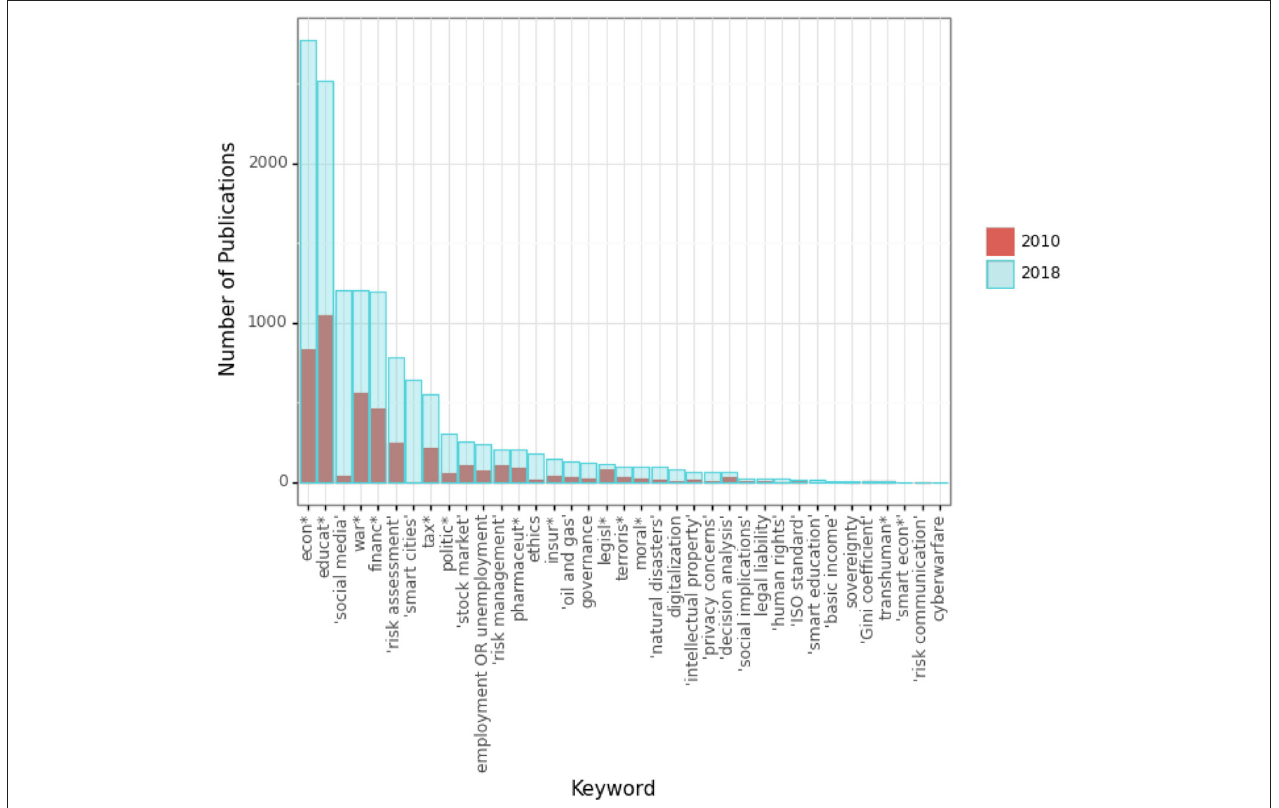
FIGURE 5 | Number of publications with each social science keyword in 2010 and